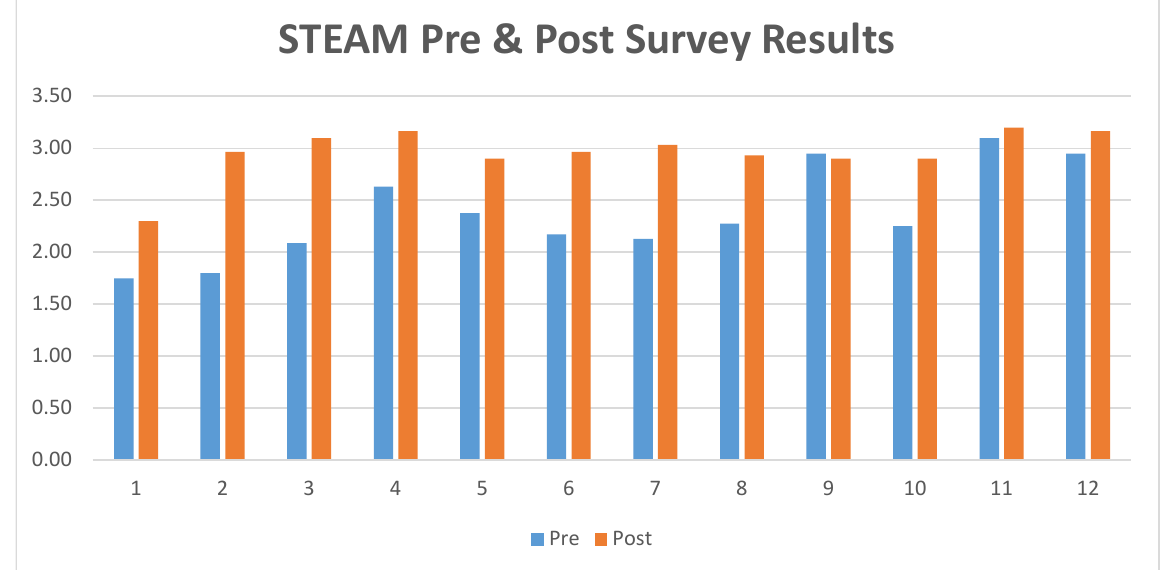
Figure 1. Preschool Teachers Pre and Post Survey Results